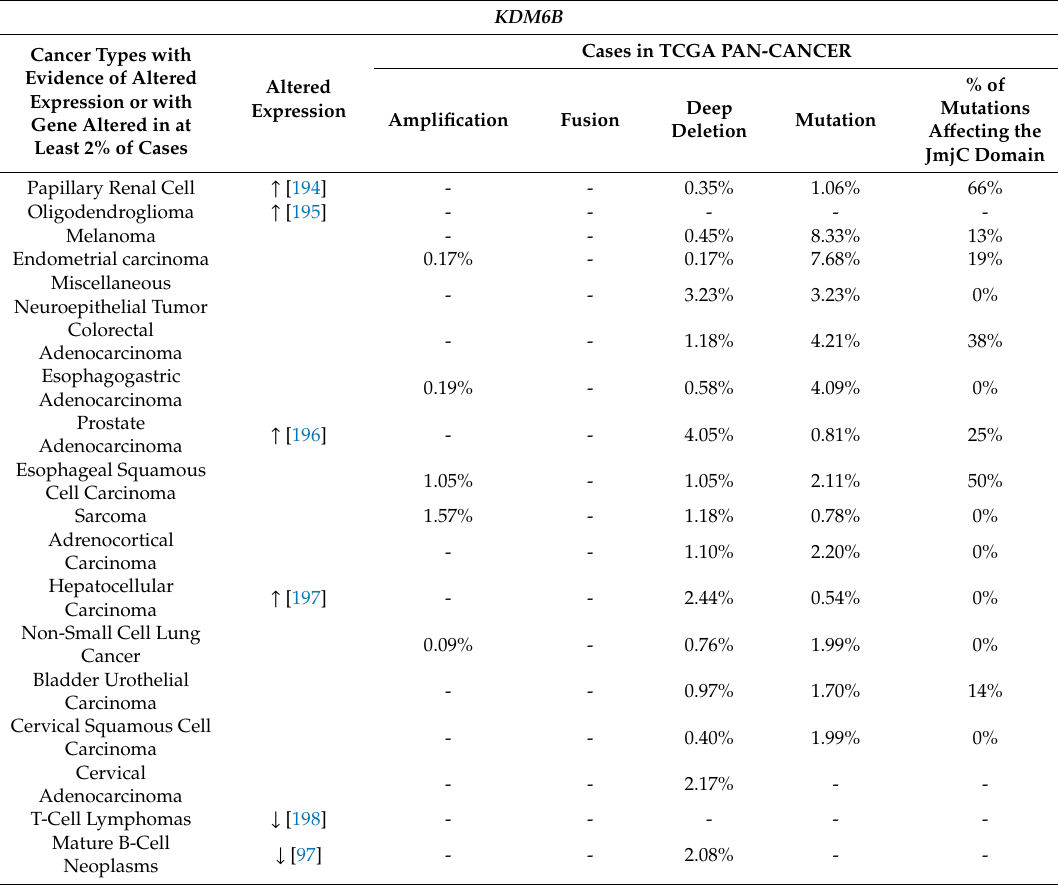
Table 3. KDM6B alterations by cancer type. Data on expression status was collected from studies deposited in Oncomine (http: // www.oncomine.org / ) or in the scientific literature. Data on mutation, gene amplification, and deletion were collected from the TCGA PanCancer dataset using cBioPortal [79,80]. Cancer types with alteration at KDM6A in at least 2% of cases are shown. All mutations within the JmjC domain or truncating mutations prior to the JmjC domain were considered to compromise enzymatic